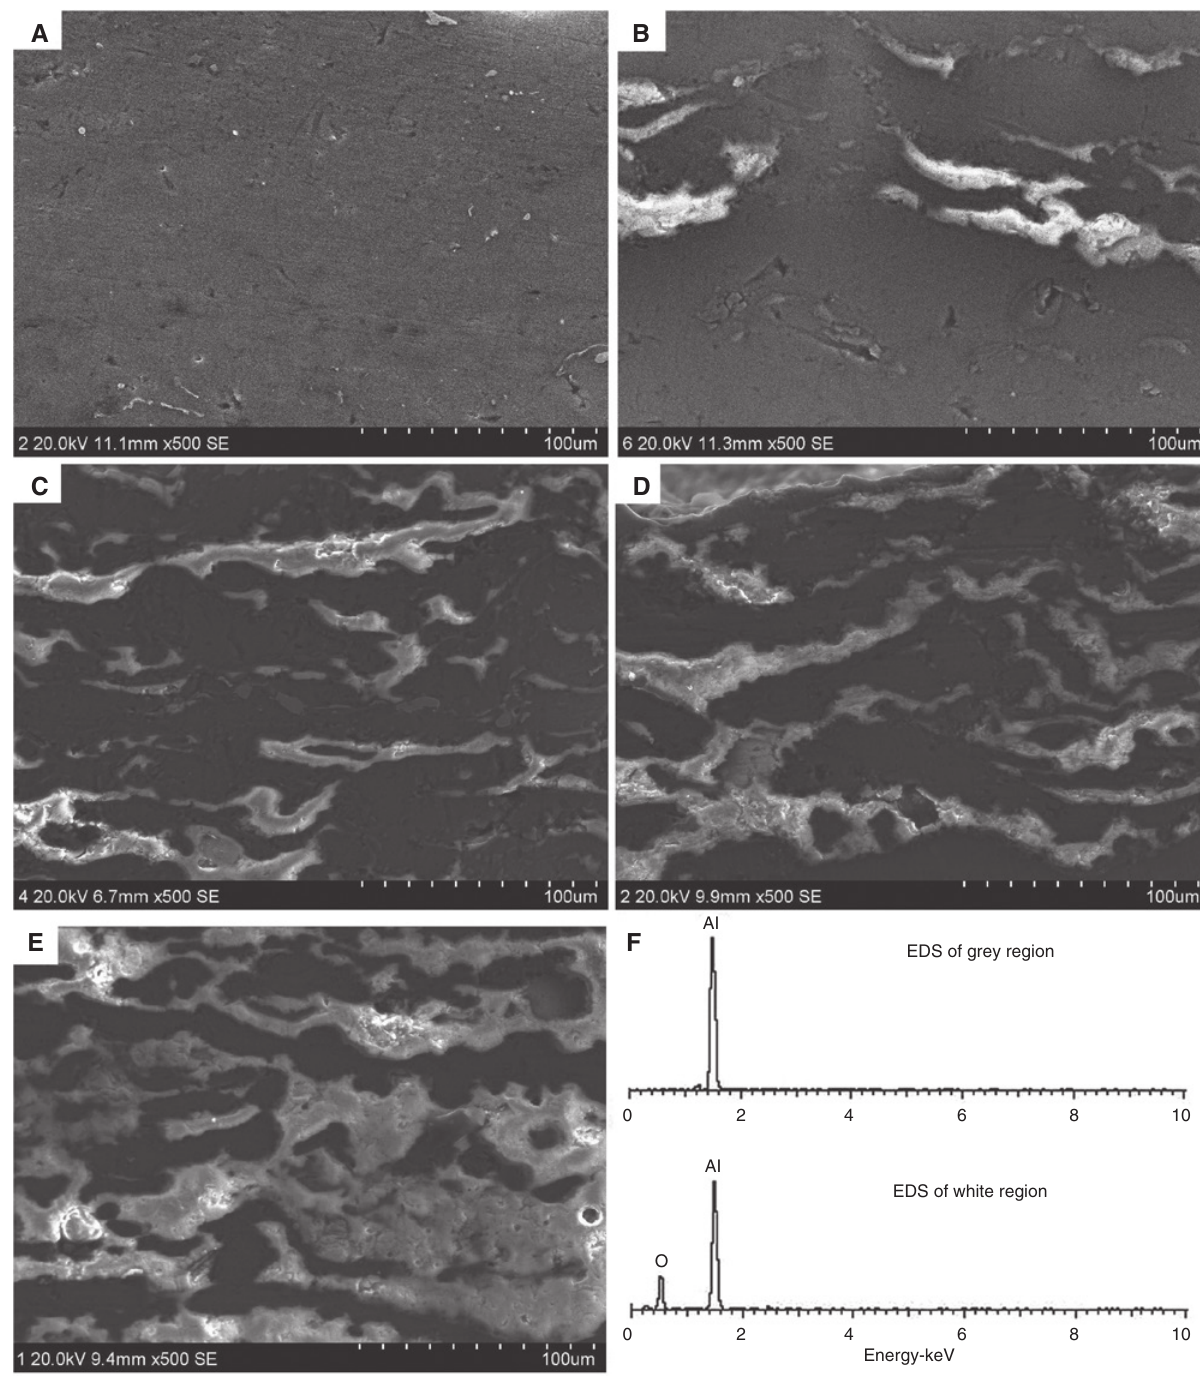
O -Al composite coatings (A) pure Al coating; (B–E) 2 3